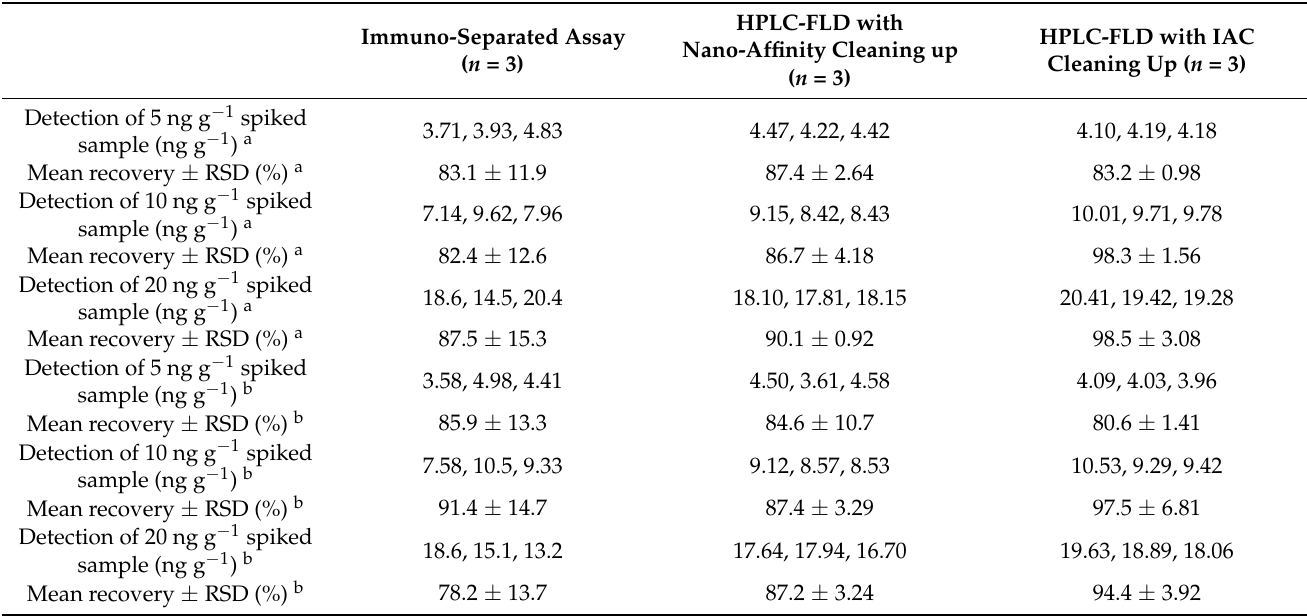
Table 5. The recoveries of OTA spiked samples detection by immuno-separated assay compared to LC-FLD with nano-affinity and IAC cleaning